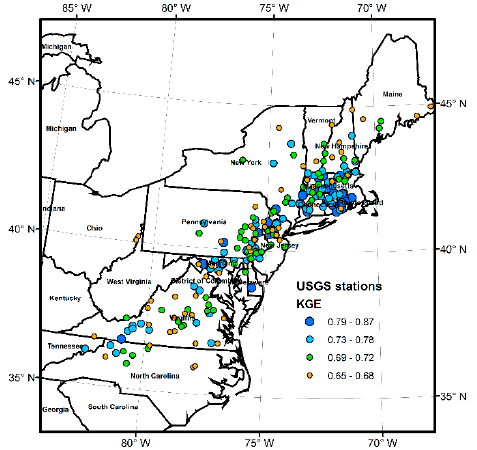
Figure 6. The 222 stations with a Kling–Gupta efficiency (KGE) above 0.65 used in the analysis of streamflow and water budget component trends. streamflow and water budget component trends.